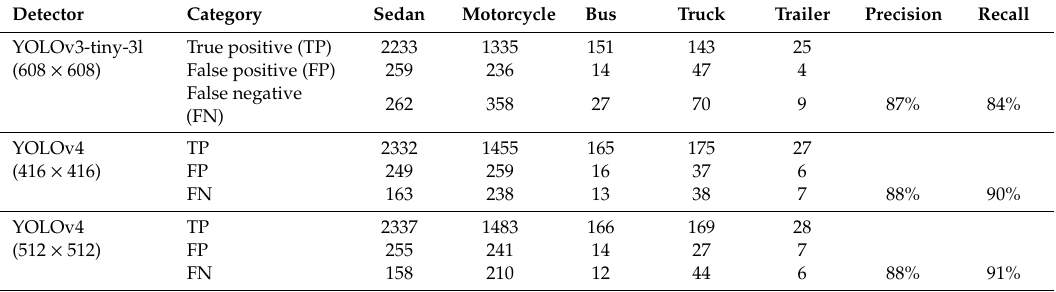
Table 1. The counts of di ff erent vehicle types based on 2439 images with YOLOv3-tiny-3l (608 ×